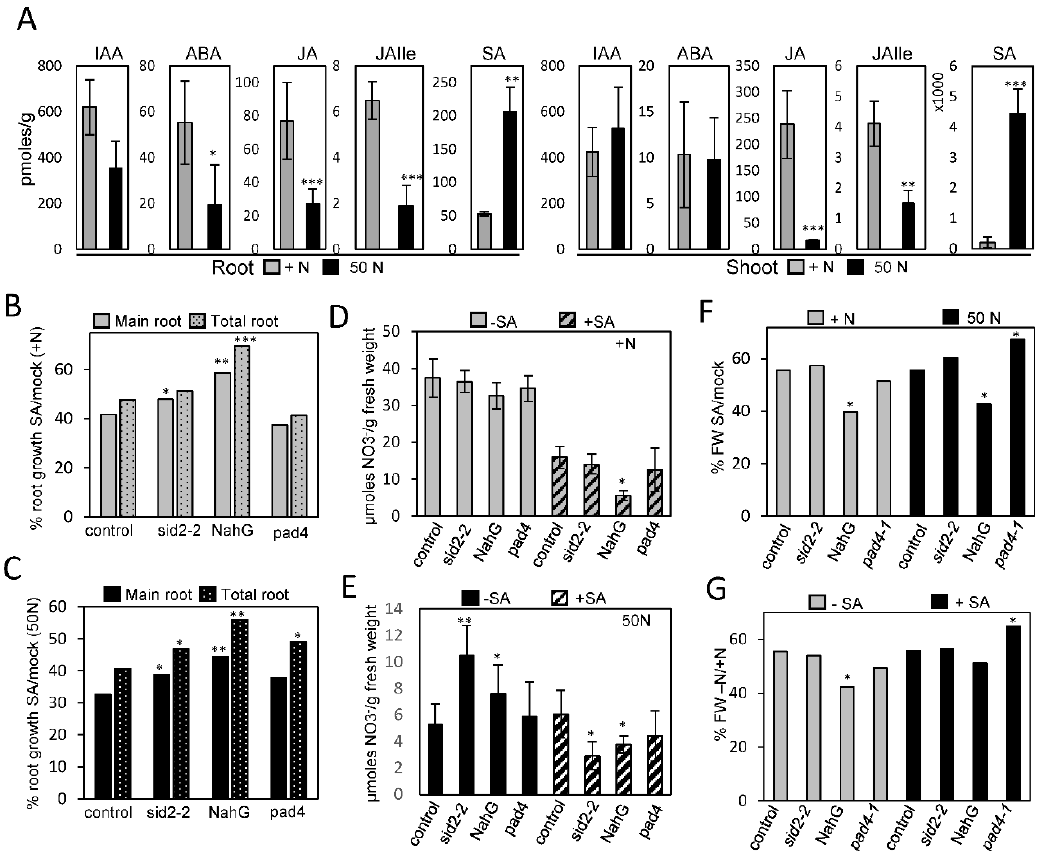
Figure 5. Effect of phytohormones in N starvation responses on roots. ( A ) Relative levels of Indol acetic acid (IAA), Abscisic acid (ABA), Jasmonic acid (JA), Jasmonic isolecuine (JAIle) and Salicylic acid (SA) in root or shoot of DGR seedlings that were cultivated in MS1/2 with high N (+N; 2500 µM) or with low N medium (50N; 50 µM) during 8 days. *, p < 0.05; **, p < 0.01; ***, p < 0.001 by t -Test comparing between high and low N. ( B , C ) Percentage of root growth (main root or main + LR length) of seedlings grown for 5 days in MS1/2 medium with high (2500 µM) (B) or low (50 µM) N (C) and then 5 days to a similar medium containing 0 or 50 µM of SA. *, p < 0.05; **, p < 0.01; ***, p < 0.001 by t -Test comparing to the control. ( D , E ) NO 3− levels in control seedlings grown in MS1/2 medium containing high N (2500 µM) (D) or low N (50 µM) (E) during 5 days and then transferred to a similar medium containing 0 or 50 µM of SA for 5 extra days. *, p < 0.05; **, p < 0.01; ***, p < 0.001 by t -Test comparing to the control in each condition. ( F ) Relative fresh weight (FW) of seedlings treated with or without SA that were grown as in (D). ( G ) Relative fresh weight (FW) of seedlings grown with or without N that were grown as in (E). *, p < 0.05; **, p < 0.01; ***, p < 0.001 by t -Test comparing to the control in each condition. Error bars correspond to S.E.